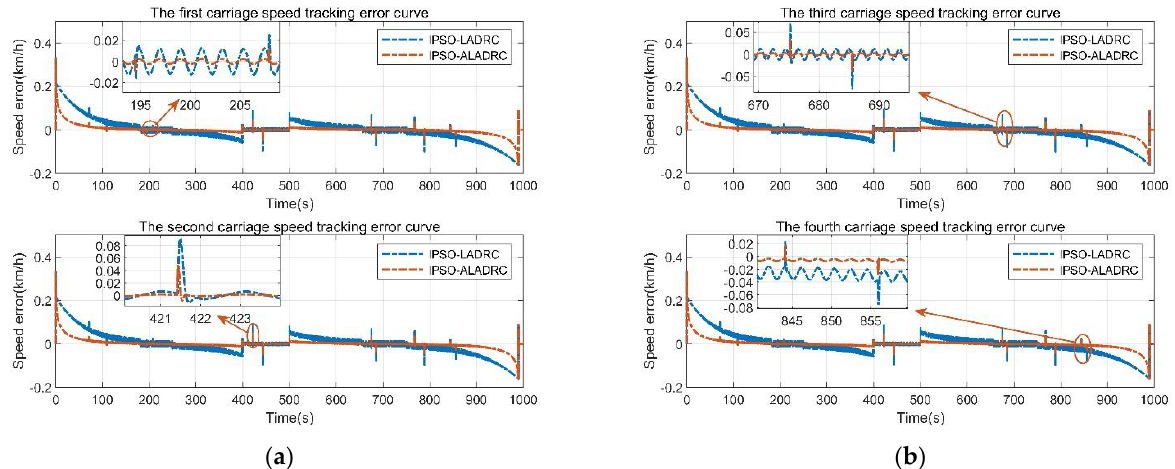
Figure 13. Speed tracking error of the four carriages: ( a ) Speed tracking error of the first two carriages; ( b ) Speed tracking error of the last two carriages.